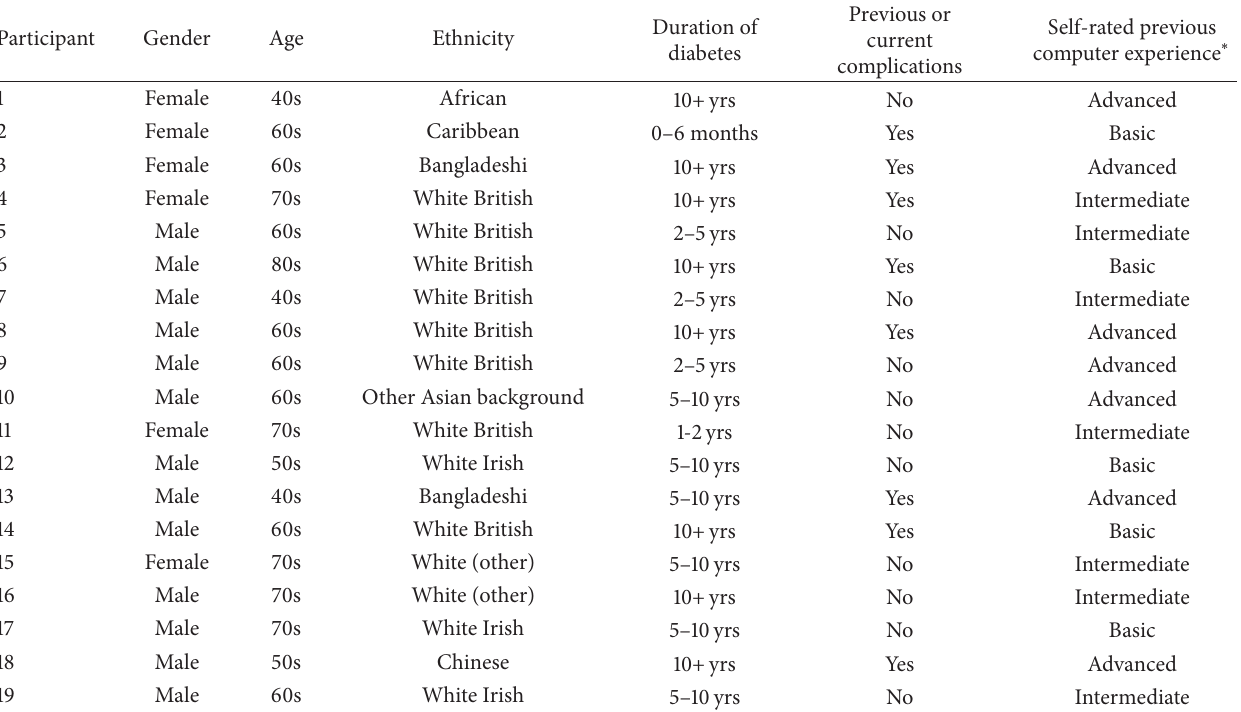
Table 2: Individual demographic information for each